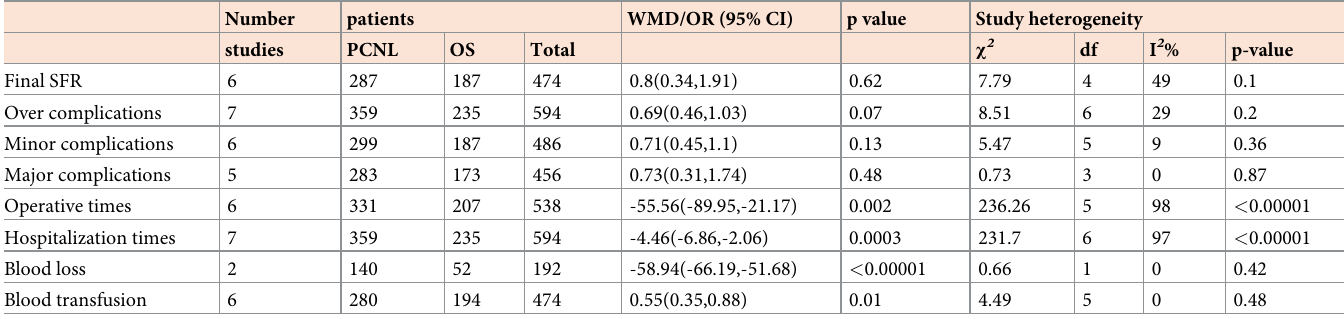
Table 3. Sensitivity analysis according to high quality studies comparing PCNL and